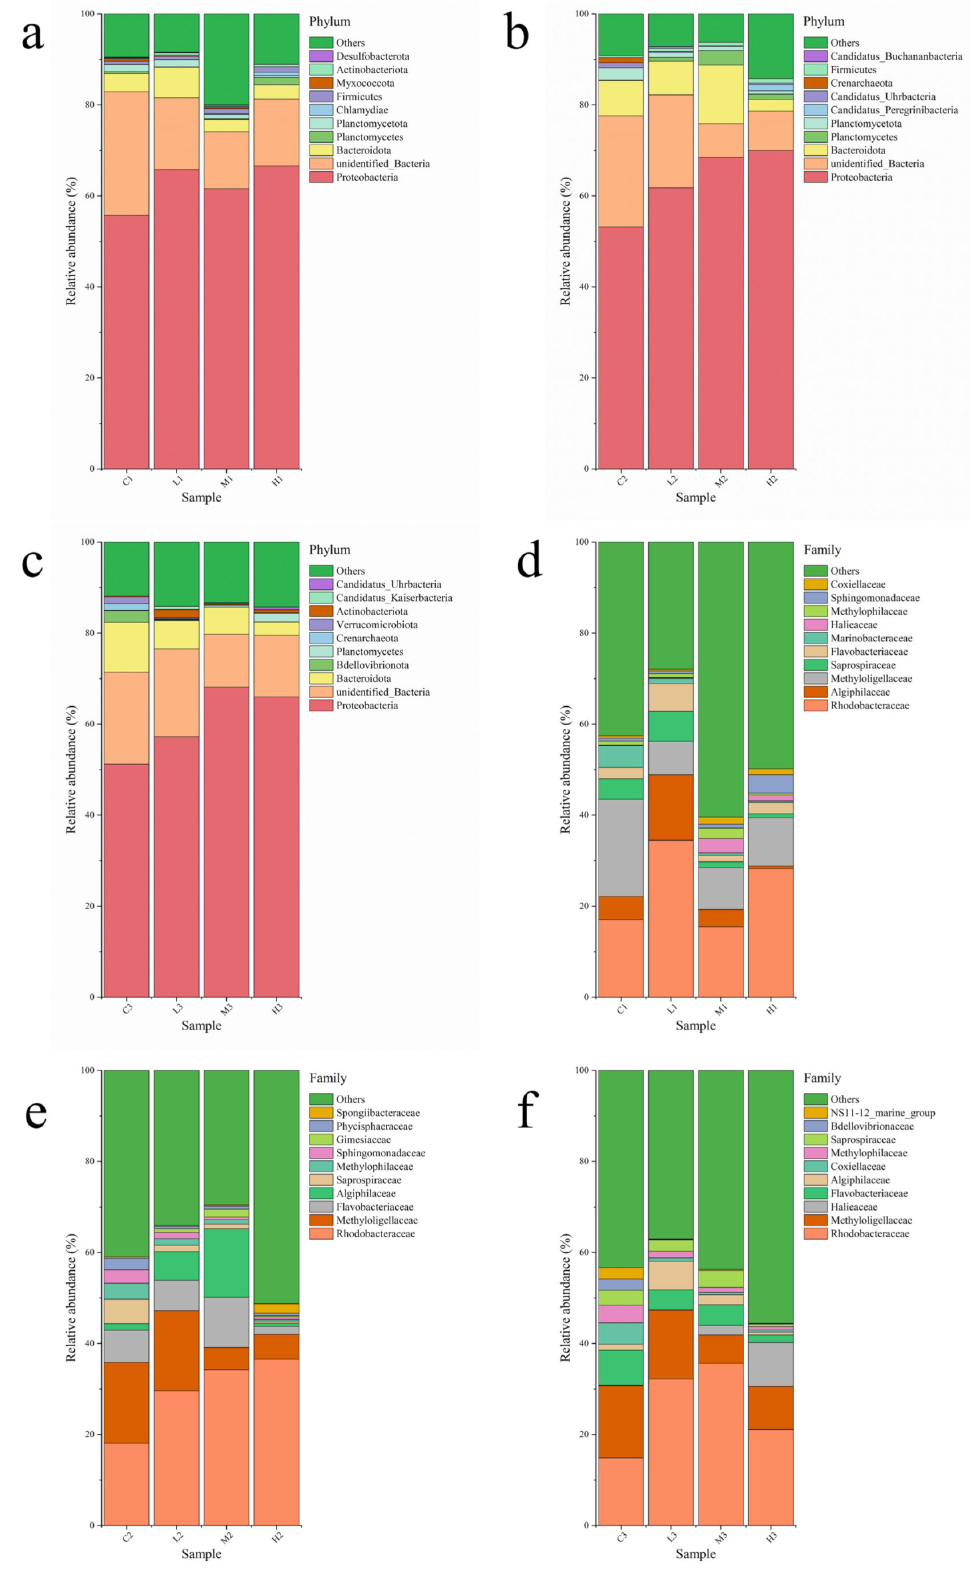
Figure 5. ( a – c ) Microbial community abundance maps at the phylum level; ( d – f ) Microbial commu- nity abundance maps at the family